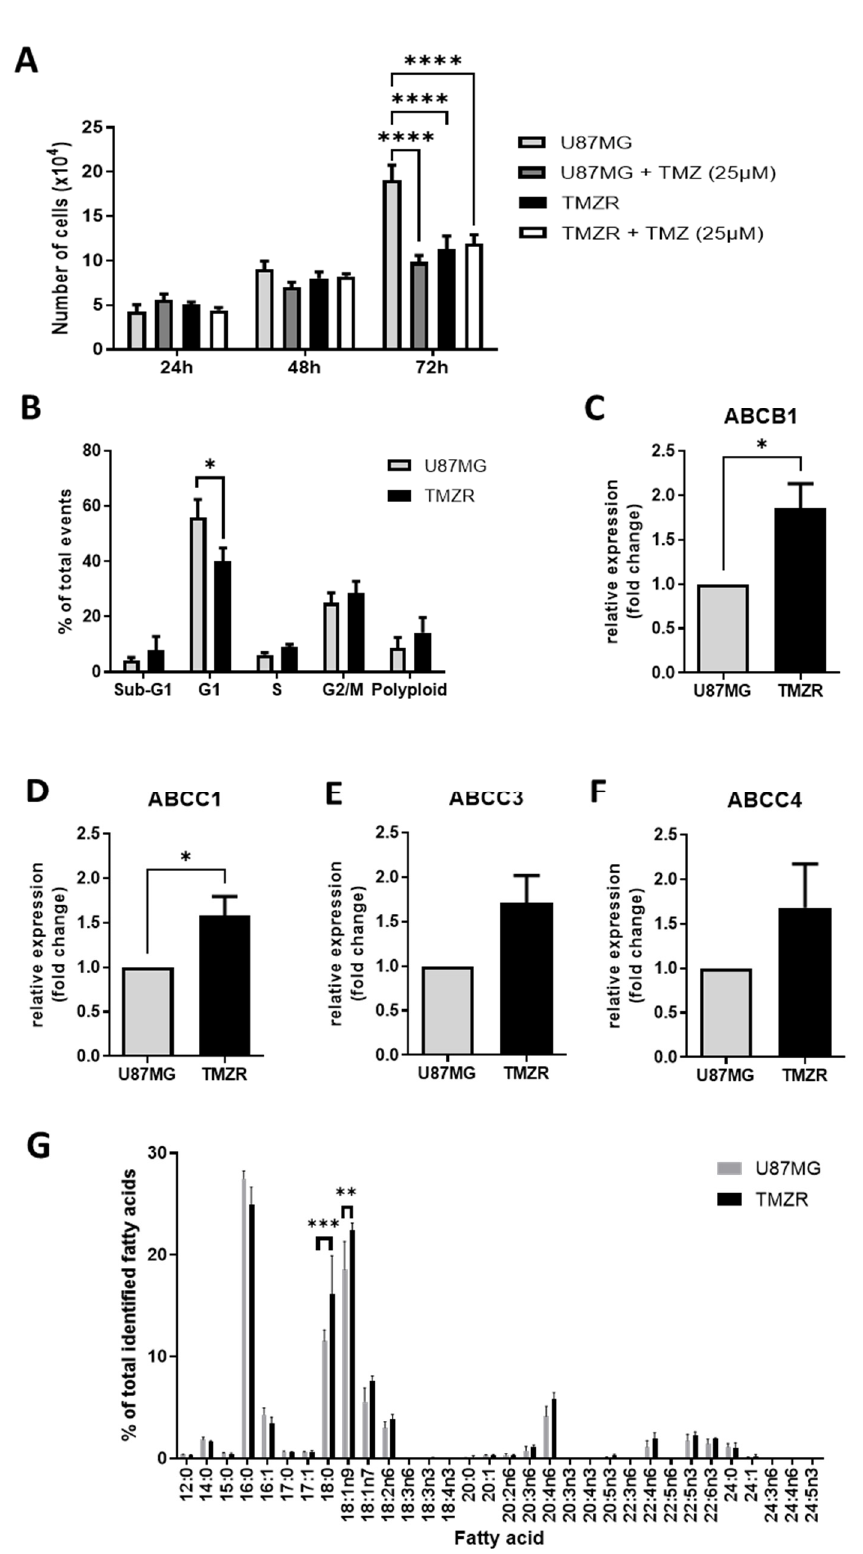
Figure 2. Effects of the development of TMZ resistance on U87MG cells: ( A ) 25 µ M TMZ in U87MG and TMZR cells; ( B ) flow cytometer analysis of cell cycle; ( C ) qRT-PCR of ABCB1 expression; ( D ) qRT-PCR of ABCC1 expression; ( E ) qRT-PCR of ABCC3 expression; ( F ) qRT-PCR of ABCC4 expression; ( G ) GCMS analysis of fatty acid composition. Data are presented as mean ± SEM, N = 3. Differences were considered significant at p < 0.05. * = p < 0.05; ** = p < 0.01; *** = p < 0.001; **** = p <